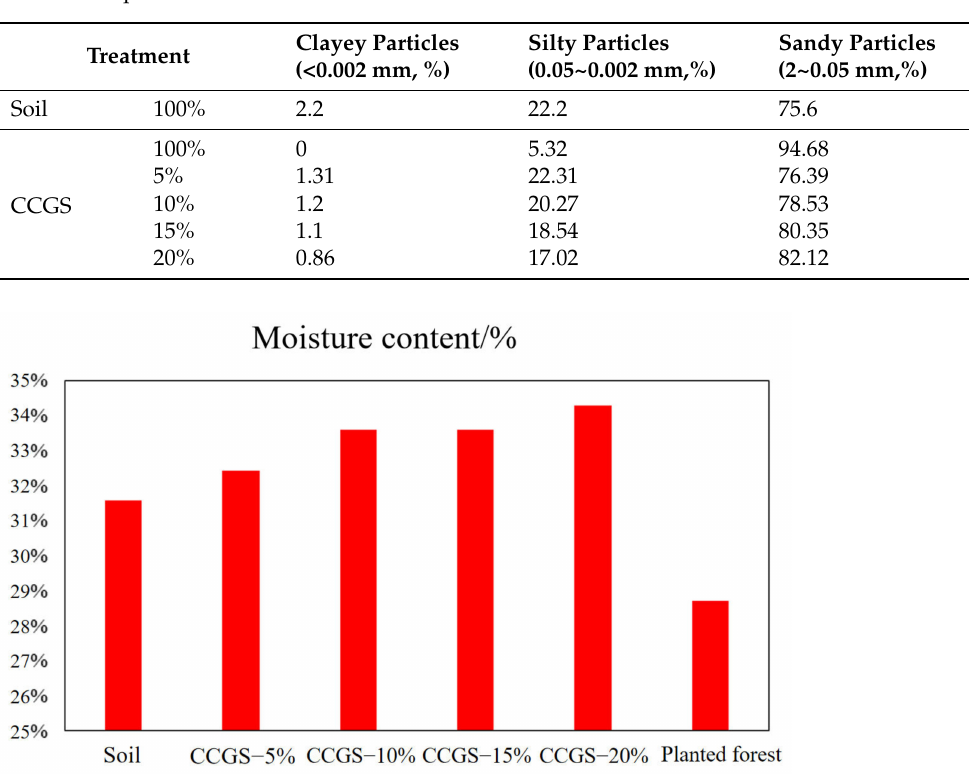
Figure 10. Effect of CCGS on soil particle size distribution with different CCGS content. Table 1. Soil particle size distribution under different content of CCGS.